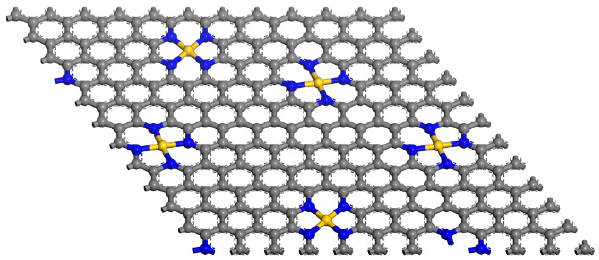
Figure 6. The sketch of experimentally fabricated M 1 N 4 /G catalyst. The generic metal atom M in gold, C in grey, N in